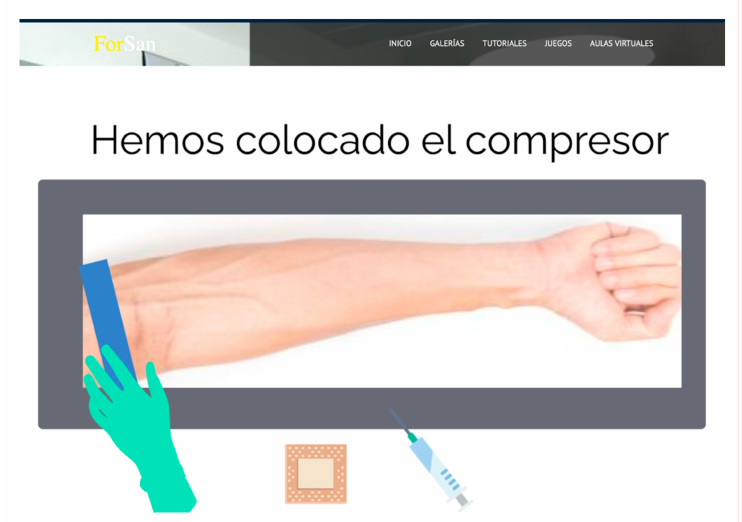
Figure 2. Flowchart of the integration of the fourth pillars in the structure of the educational methodology .